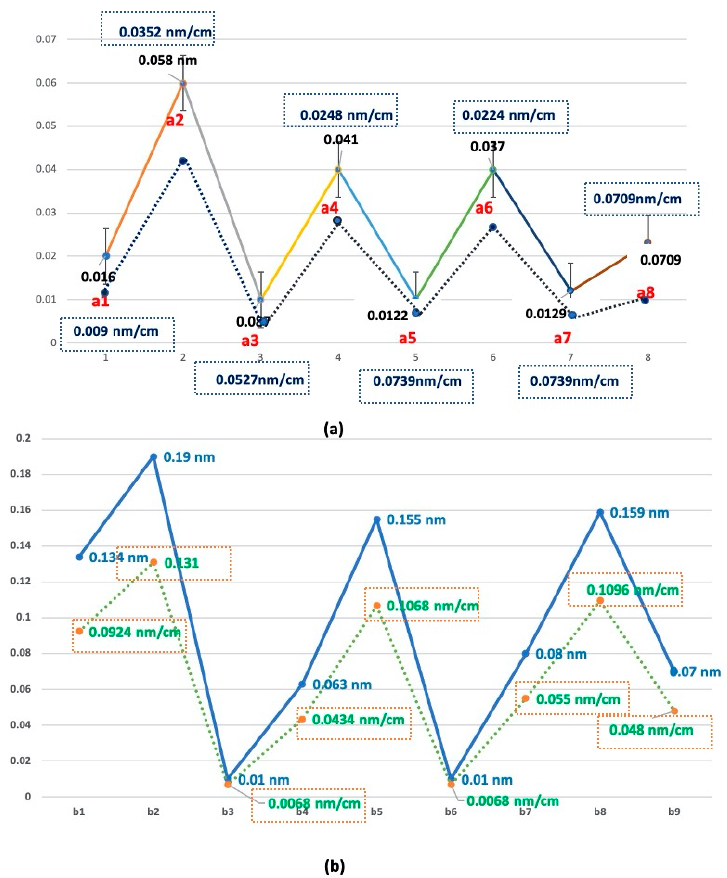
Figure 12. ( a ) unit value of the wavelength shift in horizontal section a and ( b ) unit value of the wavelength shift in vertical section b.